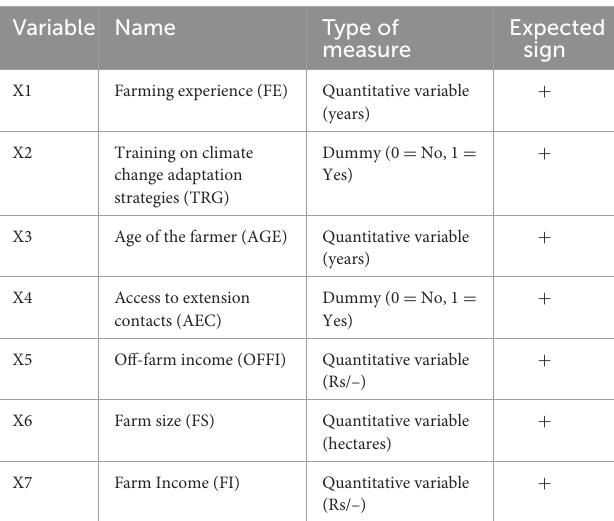
TABLE 2 Description of explanatory variables used in the discriminant